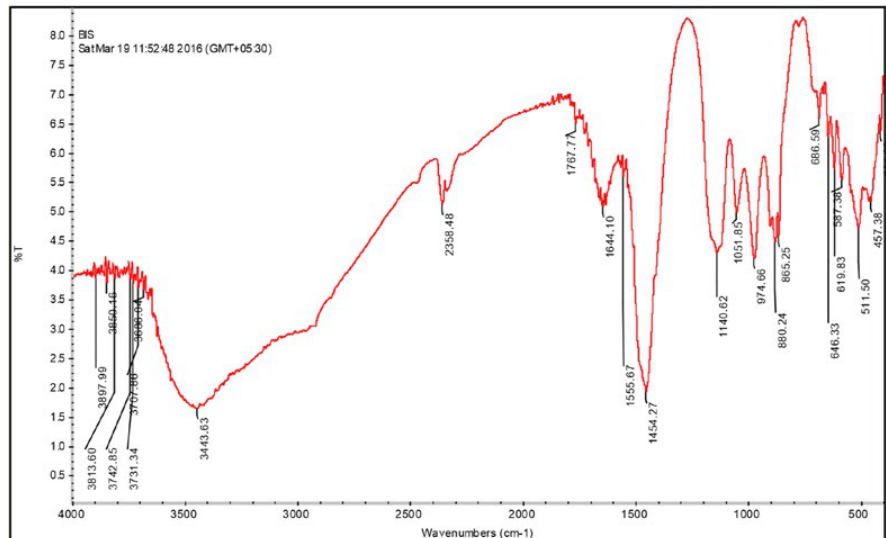
Table1. List of peaks and functional groups in ZnO-SiO